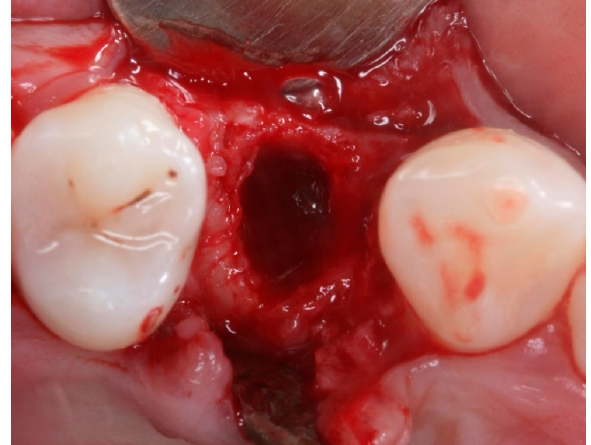
Figure 3. Intraoral occlusal view after extraction of tooth 14 (TG1).